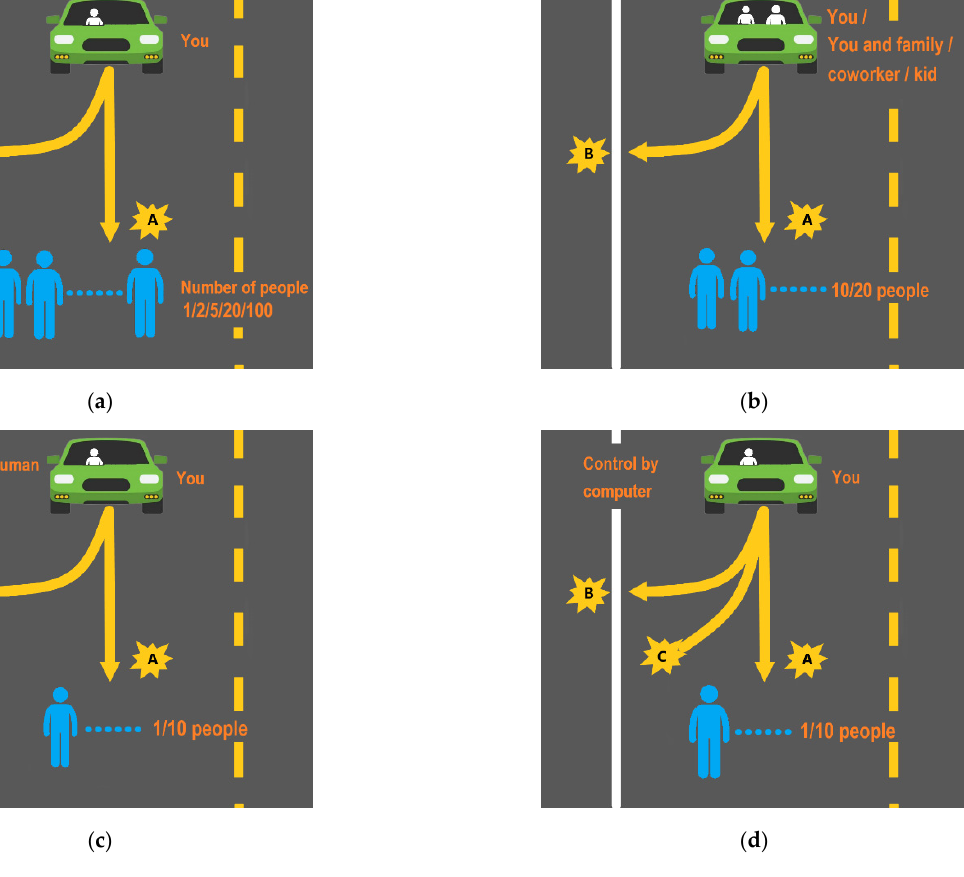
Figure 1. Scene diagram of studies. ( a ) study 1 scenario diagram; ( b ) study 2 and study 3 scenario diagram; ( c ) study 4 scenario diagram; ( d ) study 5 scenario diagram.